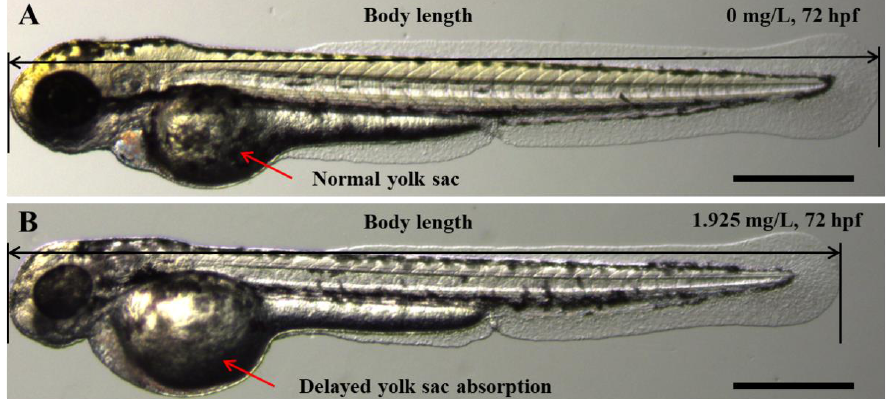
Figure 2. Representative phenotypes of zebrafish embryos upon exposure to AgNP concentration of ( B ) 1.925 mg/L, compared with the control ( A ) at 72 hpf. Scale bar = 500 μm.